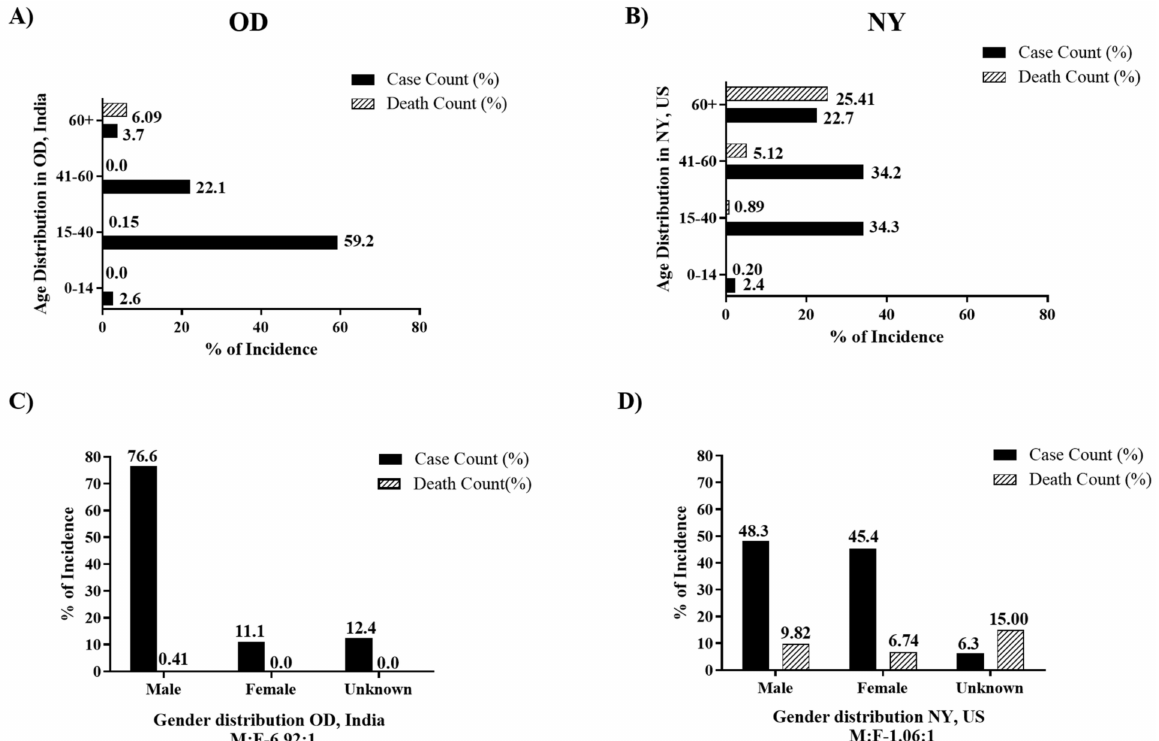
Figure 1. Age and gender distribution of COVID-19 cases from 29 February 2020 to 31 May 2020. Percentage of disease incidence within different age groups in ( A ) OD and ( B ) NY. Percentage of disease incidence within different gender in ( C ) OD and ( D ) NY. Sex ratio (i.e., male-to-female (M:F) ratio) is shown below each graph. The graph is plotted by converting case numbers to percentages of the total number to maintain the scale. Death count (%) is calculated by dividing the death cases in each age group by the corresponding confirmed case in that age group. Abbreviations: OD, State of Odisha, India. NY, State of New York,